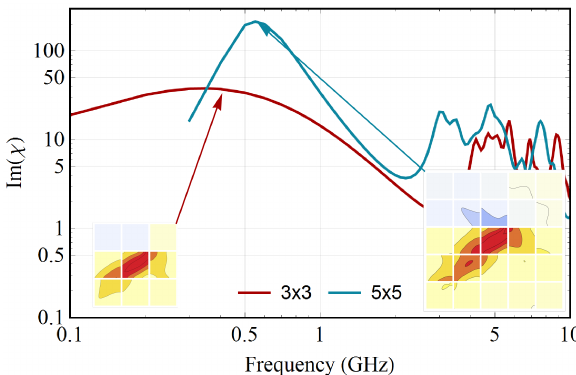
Figure 8. Ordered arrays of nanoplatelets with an o ff -centered macro-vortex state without a vortex core. Im χ xx spectra for two array sizes 3 × 3 and 5 × 5. Regime of strong dipolar coupling ( δ = 3 nm). The insets correspond to the local susceptibility maps (imaginary part) of the low-frequency resonance for the two array sizes. The color code is the same as in Fig. 2.